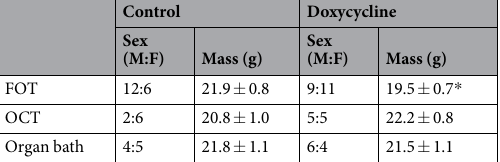
Table 1. Group characteristics. Mean ± SE, * p < 0.05. FOT, forced oscillation technique; OCT, optical coherence